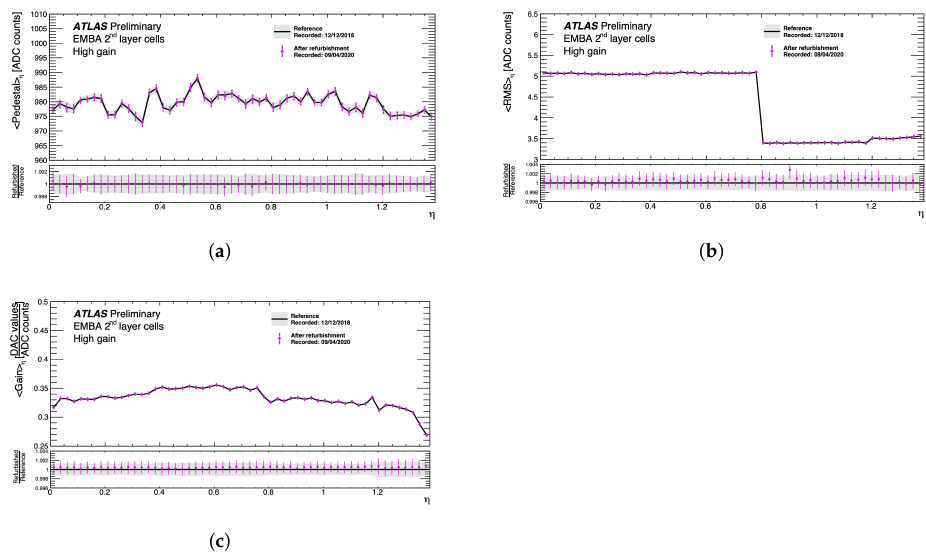
Figure 6. Mean pedestal values in ADC counts ( a ), mean value of the RMS in ADC counts ( b ) and mean value of the gain over the LAr Calorimeter cells ( c ), in a given pseudorapidity ( η ) range. Only the cells of the second layer of the electromagnetic barrel on side A (EMBA) are included. The black line shows the values measured at the end of Run 2. The purple dots show the values measured after the refurbishment of the front-end crates and front-end